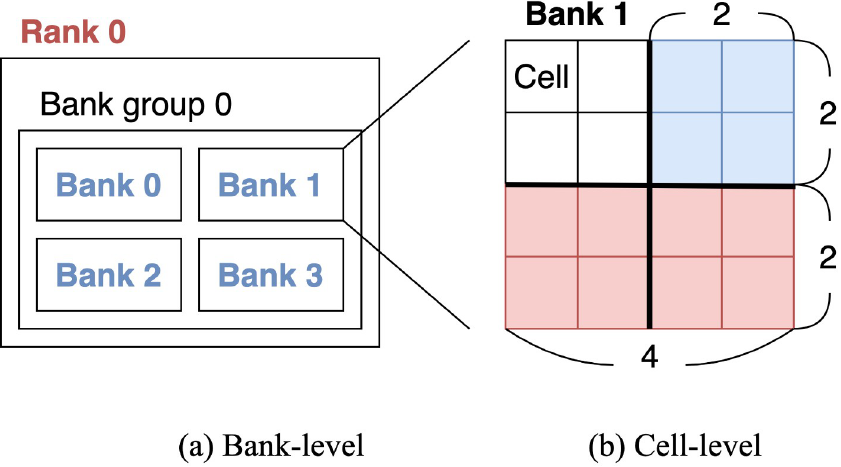
Fig 4. An example of constructing bank-level and cell-level super features. (a) shows a bank-level super feature extracted from rank, bank group, and bank fields. (b) shows a cell-level super feature including the address field. Features and super features are denoted as blue and red colors,